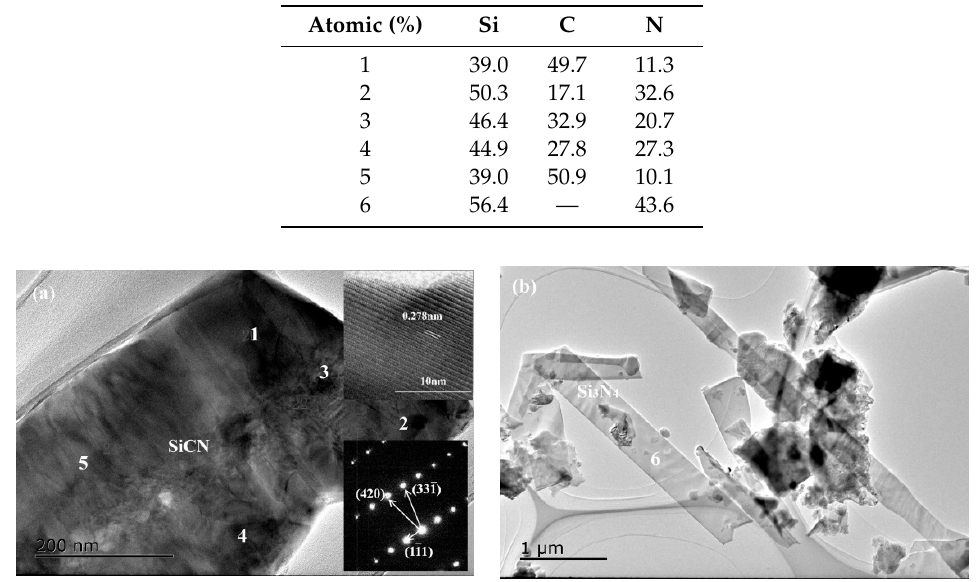
Figure 13. TEM images and electron diffraction patterns of sample A synthesized at 1550 °C (Si:C = Figure13. TEMimagesandelectrondi ff ractionpatternsofsampleAsynthesizedat1550 ◦ C(Si:C = 1.5:1): 1.5:1): ( a ) SiCN and ( b ) Si 3 N 4. ( a ) SiCN and ( b ) Si 3 N 4